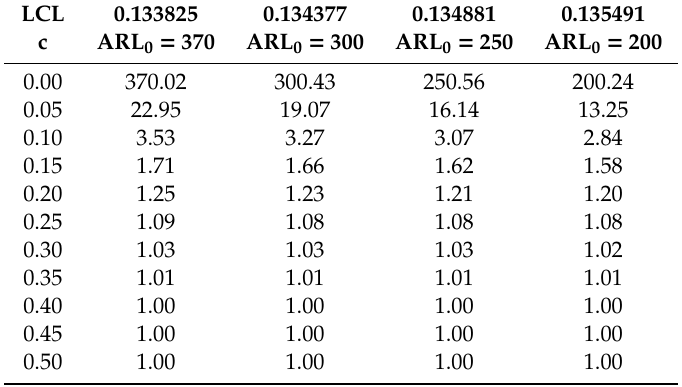
Table 12. The ARLs for the proposed chart when n = 50, GD (0.5,1.00), USL = 3.9397, and LSL =